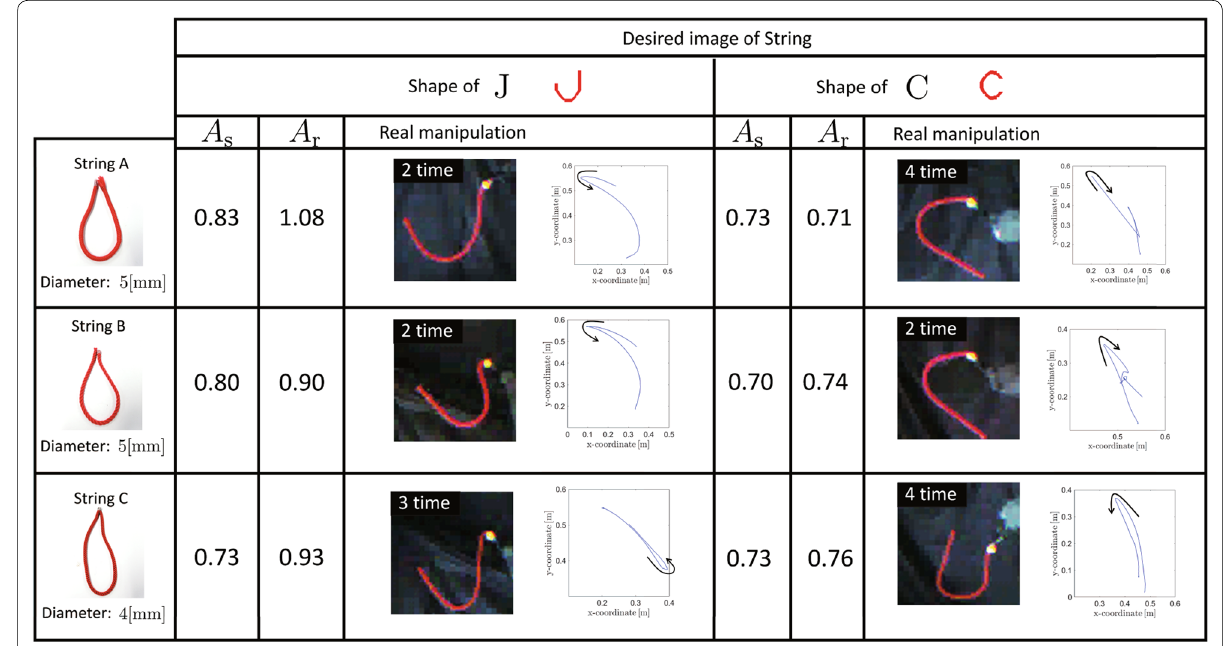
Fig. 19 Experimental results about manipulating strings with various properties